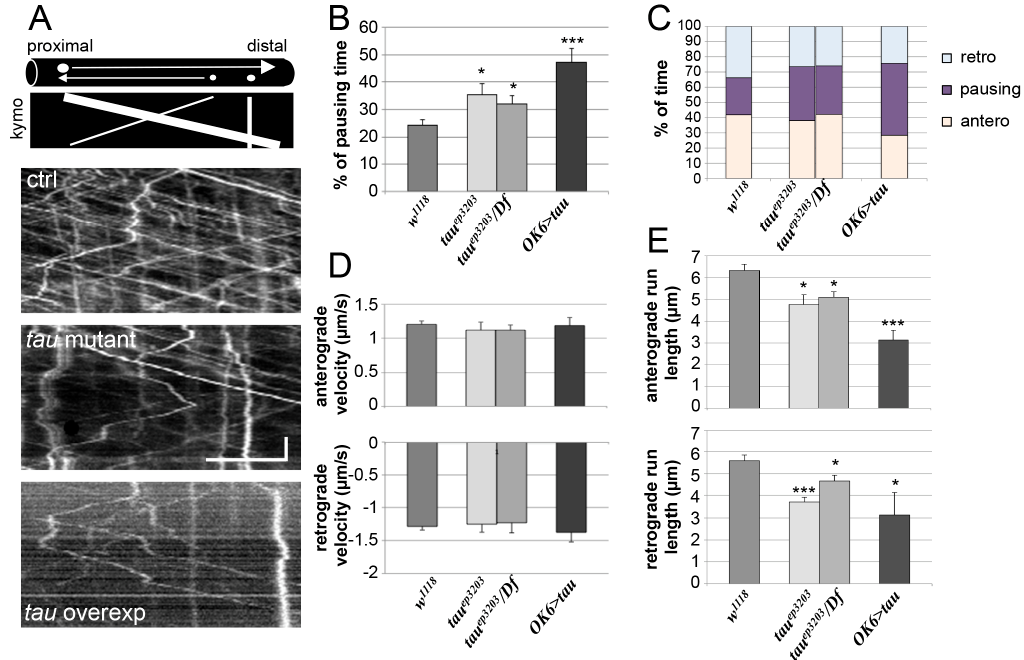
Figure 5. Vesicular axonal transport in tau mutants and tau -overexpressing larvae. ( A ) Examples of vesicular tracking analysis: for each genotype, a representative kymograph is shown. Kymographs allow the visualization of the movement of all vesicles within a selected axonal segment versus time. Diagram in ( A ) illustrates the trace of a vesicle moving anterogradely (e.g., with a large vesicle) or retrogradely (e.g., with a small vesicle). Immobile vesicles lead to vertical traces (e.g., with a medium size vesicle). The exact genotypes analysed were males w/Y ; OK6-Gal4/+ ; UAS-NPY-GFP/+ as the control, w/Y ; OK6-Gal4/+ ; UAS-NPY-GFP tau ep3203 /tau ep3203 or w/Y ; OK-Gal46/+ ; UAS-NPY-GFP tau ep3203 /Df(3R)BSC498 as the tau mutants and w/Y ; OK6-Gal4/UAS-dTau1 ; UAS-NPY-GFP/+ . Horizontal scale bar is 5 μ m and vertical scale bar is 10 s. Histograms of the percentage of pausing ( B ), the percentage of time spent in anterograde or retrograde movement, or pausing ( C ), the instant anterograde (positive values) and retrograde (negative values) velocities for each genotype ( D ): n = 15 larvae for the control genotype; n = 11 and 7 larvae for tau ep3203 mutants and tau ep3203 /Df(3R)BSC498 mutants respectively; n = 11 for tau- overexpressing larvae. For each larva, a number between 10 and 20 vesicles were tracked and their kinetic parameters quantified. ( E ) Histograms of the mean vesicle run length either for anterograde movement or retrograde movement: n = 6 larvae (83 vesicles) for the control genotype; n = 5 and 6 larvae (71 and 63 vesicles) for tau ep3203 mutants and tau ep3203 /Df(3R)BSC498 mutants respectively; n = 5 larvae (74 vesicles) for tau- overexpressing larvae. Data are: mean +/ − SEM. * p < 0.05, *** p < 0.001 (Student’s t -test).